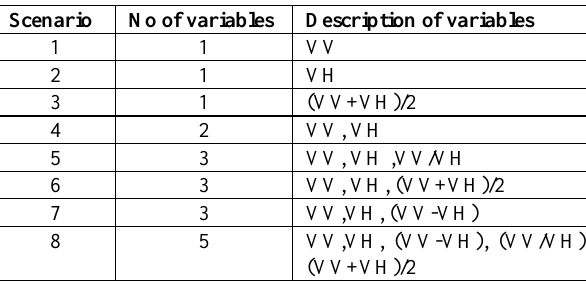
Table 3. Dataset of experiments for land cover classification